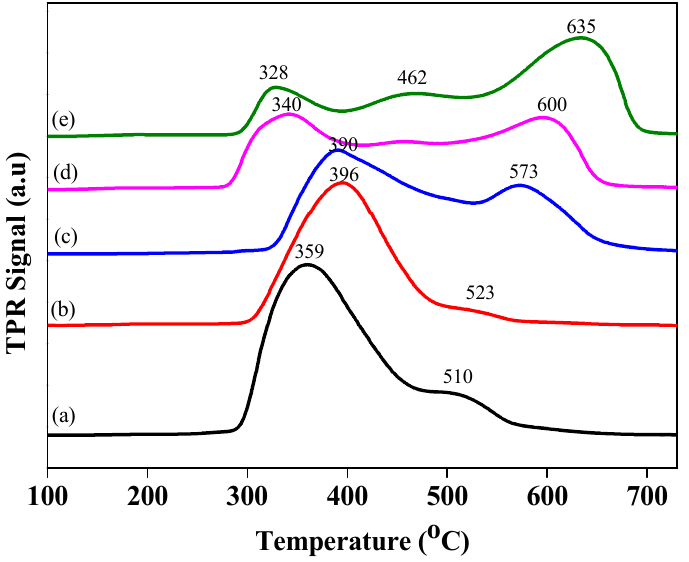
Figure 6. H 2 -TPR patterns of ( a ) Ni-Z50, ( b ) Ni-HZ-0.2 M, ( c ) Ni-HZ-0.5 M, ( d ) Ni-USY80, and ( e ) Ni-HZ-USY80 samples.